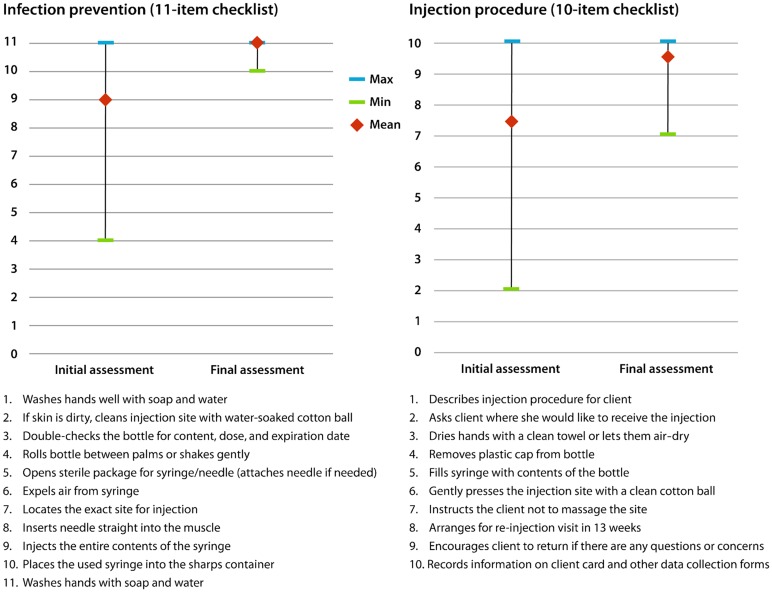
Safety of CHW Provision of InjectablesAbbreviations: CHW, community health worker.